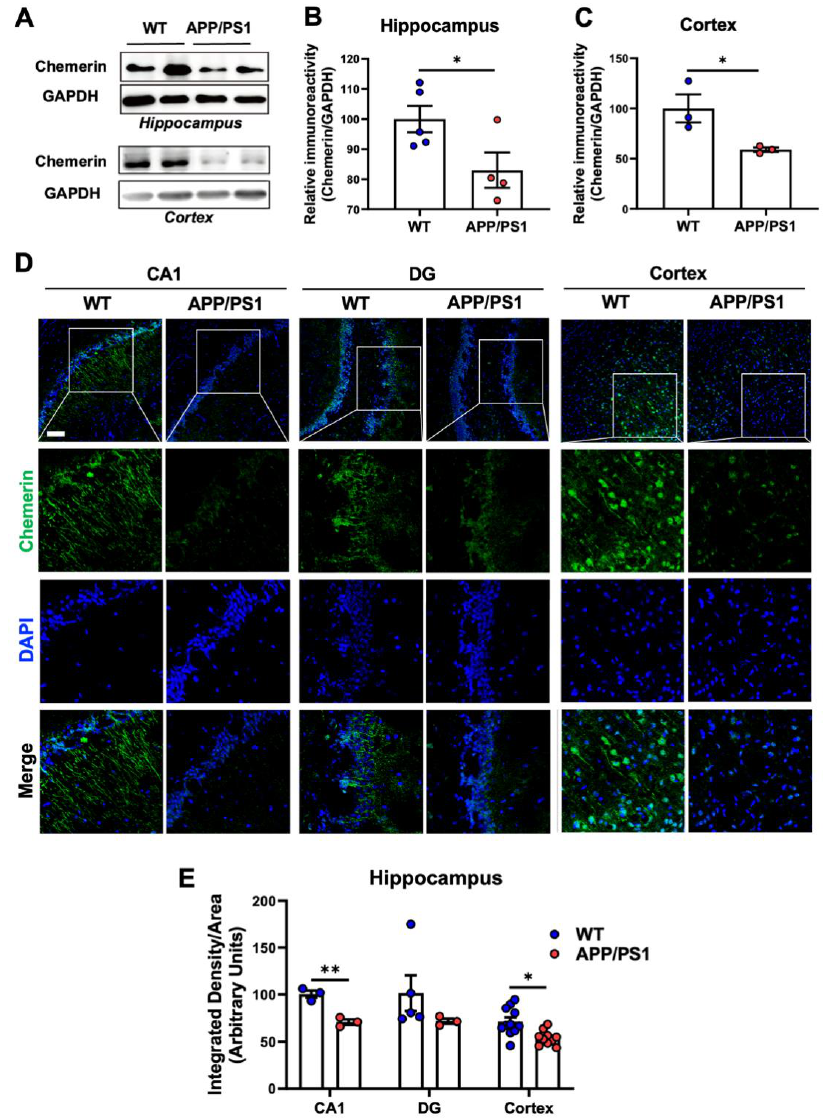
Figure 2. Decrease of chemerin in the hippocampus and cortex of APP/PS1 transgenic mice. ( A ) Representative Western blot showing the expression of chemerin in the hippocampus and cortex in 9-month-age WT and APP/PS1 mice. ( B , C ) Quantification of immunoreactivity of the blots, normalized against GAPDH. ( D ) Serial sections of 9-month-old WT and APP/PS1 transgenic mouse brains were stained for chemerin using a rabbit anti-chemerin polyclonal antibody and then further treated with Alexa Fluor 488-conjugated anti-rabbit IgG (green fluorescence). Cell nuclei were stained with DAPI (blue fluorescence). Immunofluorescence was examined under a confocal laser-scanning microscope. Scale bar, 50 μm. Selected areas are enlarged by 4 times and shown as combined as well as individual fluorescence stains. ( E ) Quantification of the chemerin fluorescence was shown. The results are expressed as the mean ± SEM on each region by using at least 3 mice in each group. * p < 0.05, ** p < 0.01.